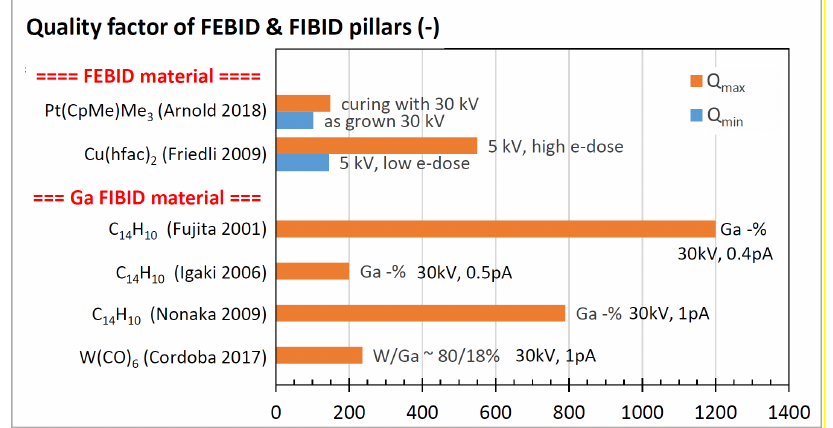
Figure 19. Reported quality factors for FEBID and FIBID pillars from vacuum, room temperature vibration experiments in the range of 0.1 to 1 MHz.